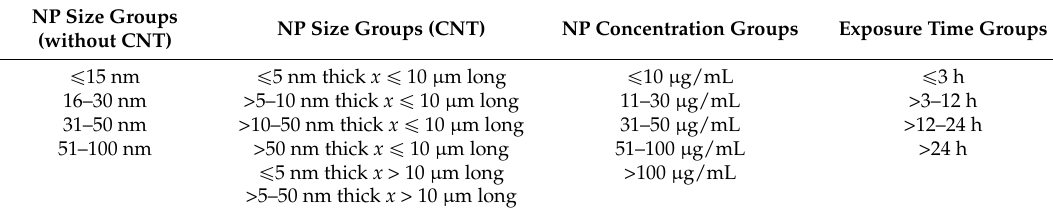
Table 2. Classification of data points into NP-size groups, NP-concentration groups and exposure time groups. If possible, each group contains at least five data points.